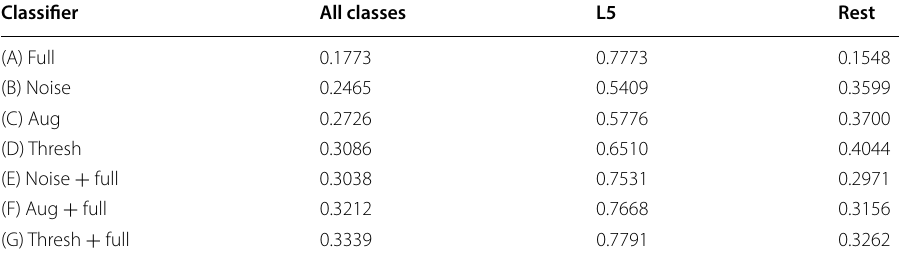
Table 5 Two-phase learning with WHOI-Plankton (Avg. F1-score)